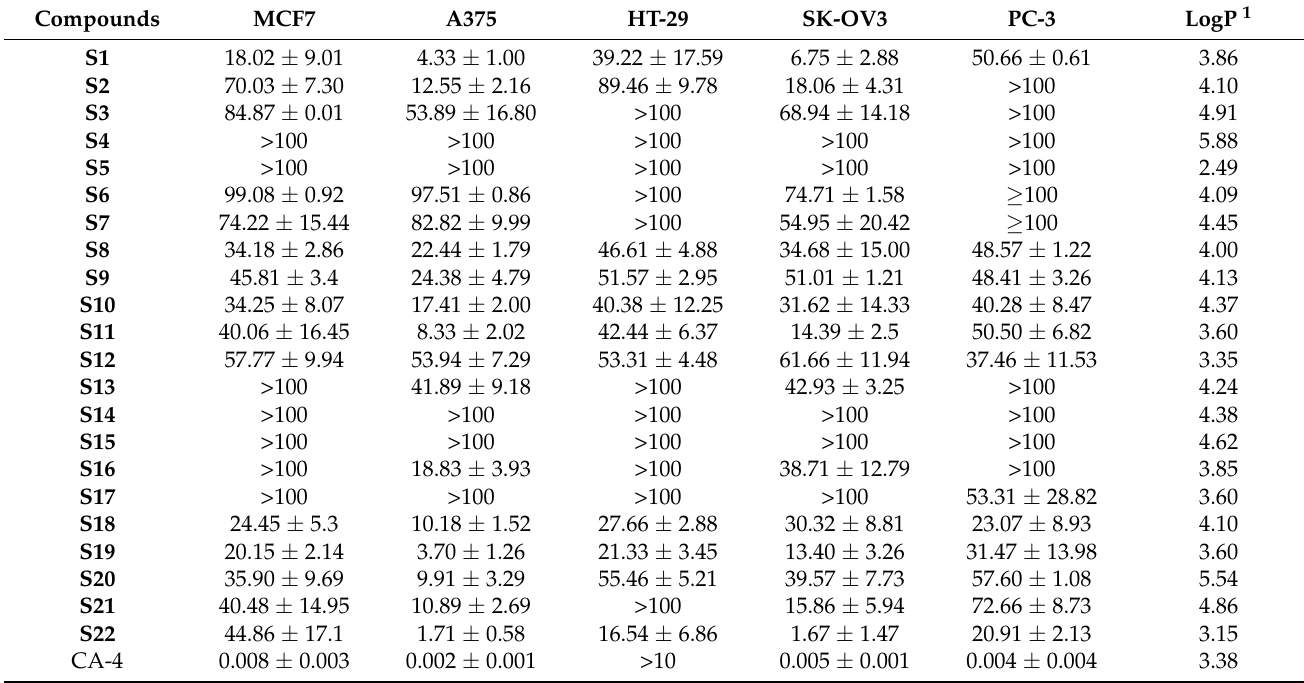
Table 1. The IC 50 values ( µ M) determined using WST-1 assay after 48 h of treatment. Data are expressed as the mean ± SD from at least three independent